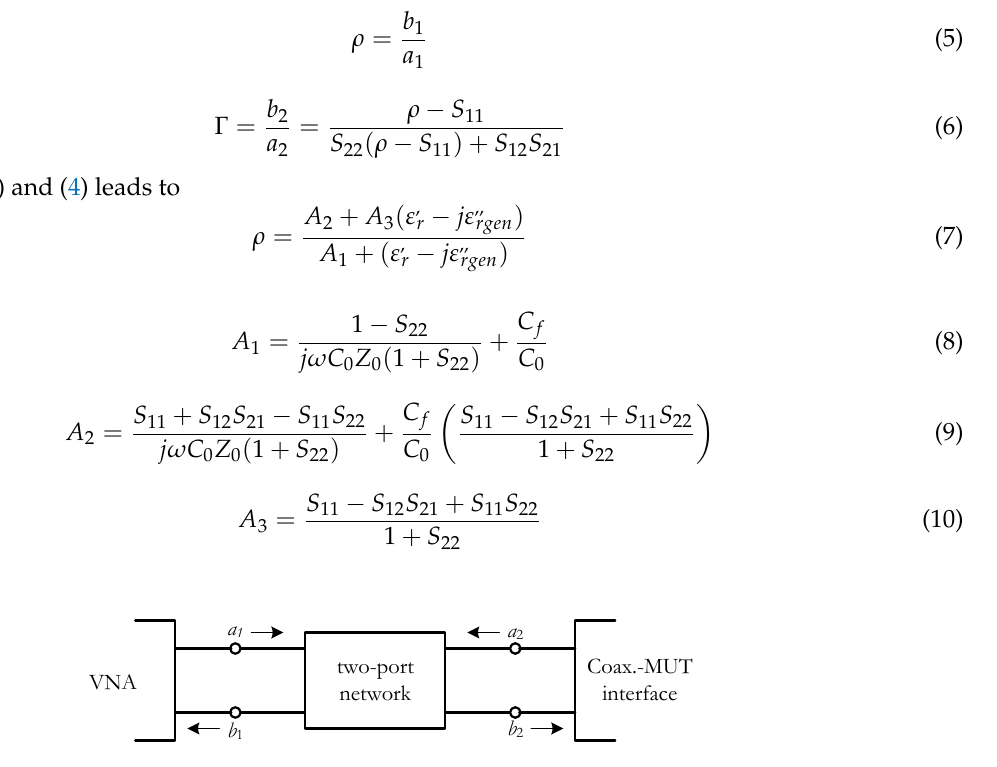
Figure 4. Two-port model of the coaxial probe